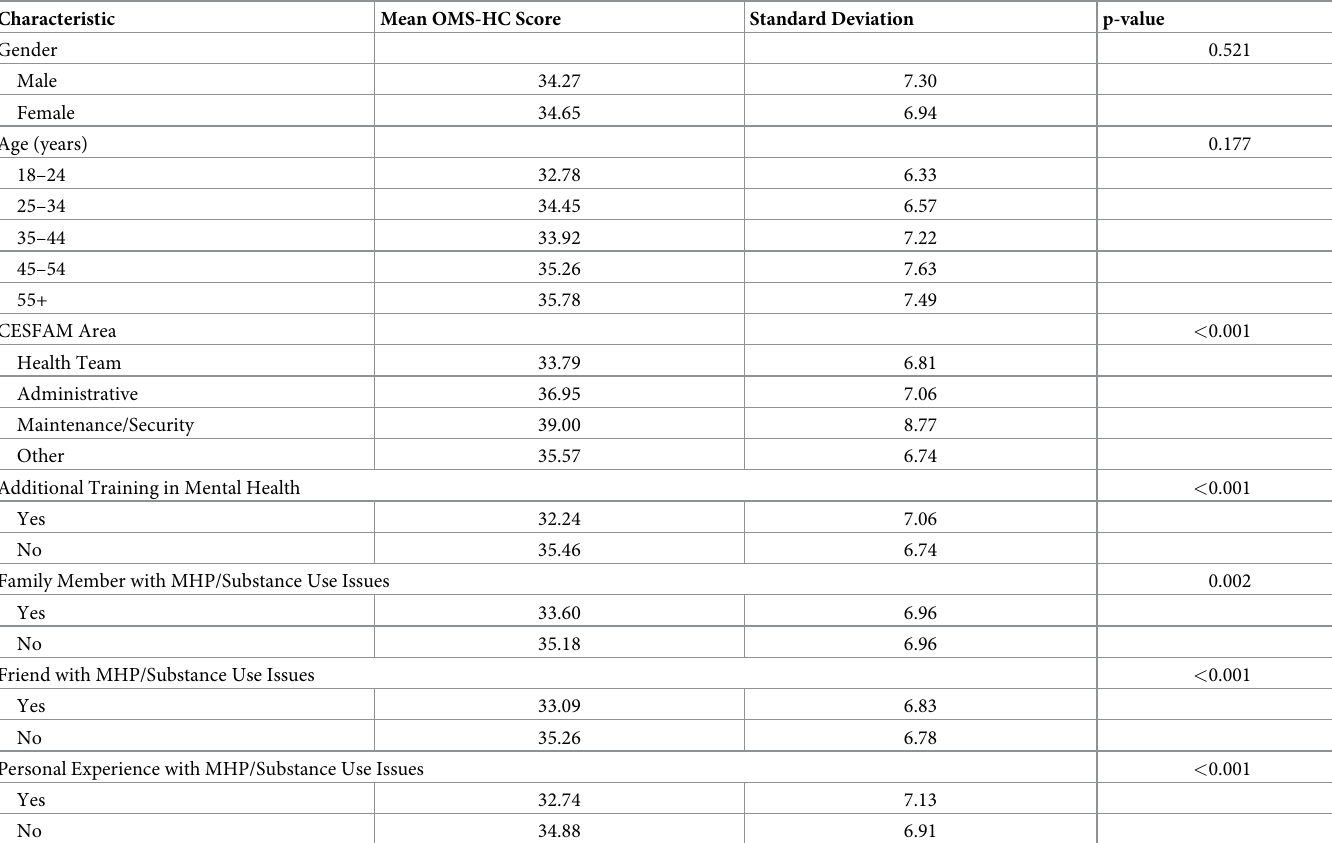
Table 4. Mean Opening Minds Scale for Health Care Providers (OMS-HC) scores by sociodemographic